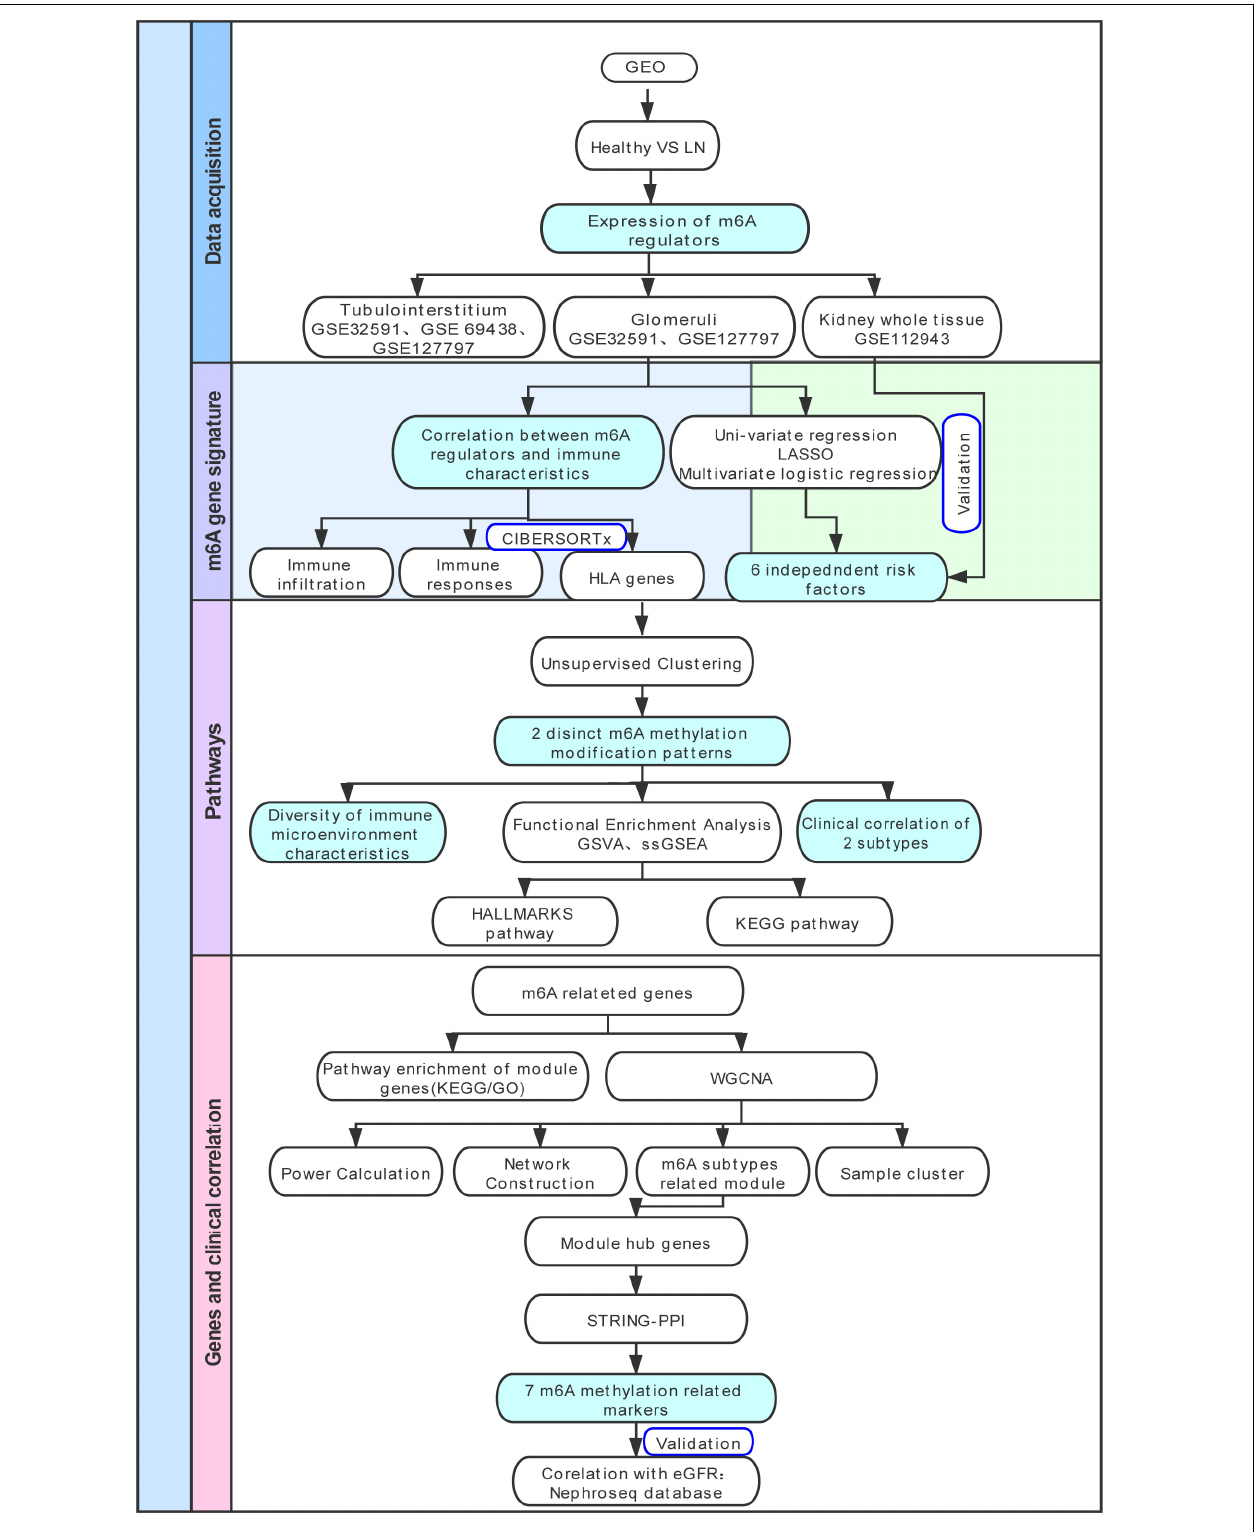
FIGURE 1 | Study flow diagram. GEO, Gene Expression Omnibus; LN, lupus nephritis; HLA, human leukocyte antigen; LASSO, least absolute shrinkage and selection operator; GSVA, gene set variation analysis; ssGSEA, single sample gene set enrichment analysis; KEGG, Kyoto Encyclopedia of Genes and Genomes; GO-BP, Gene Ontology Biological Processes; WGCNA, weighted gene co-expression network analysis; GO, Gene Ontology; PPI, protein-protein interaction.